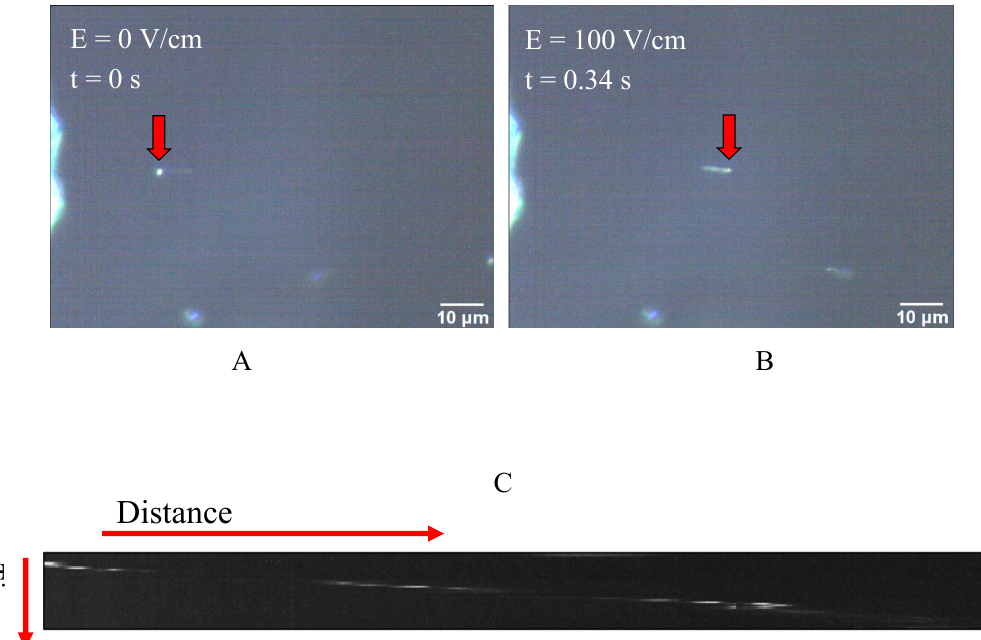
Figure 2. ( A , B ) Two represented snapshots show the movement of a bead as the electric field is implemented; ( C ) An example of a kymograph obtained from the darkfield microscopy images, which indicates the movement of the microspheres inside the capacitor and under the influence of the electric field.